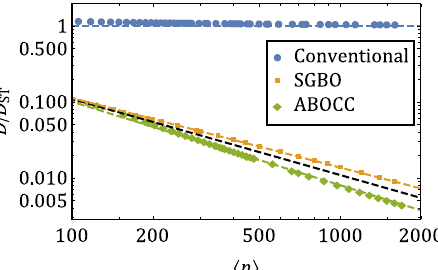
Fig. 2 Laser linewidth as a function of the average number of photons 〈 n 〉 in the laser cavity for conventional, Susskind – Glogower Bare Operator (SGBO), and Approximately Bare Operator Coupling Circuit (ABOCC) lasers. The laser linewidth is in units of the generalized Schawlow – Townes linewidth. Engineering of the atom-cavity coupling and the photon loss allows both the SGBO and the ABOCC lasers to achieve a linewidth signi fi cantly narrower than the best conventional laser. The dots represent the numerically calculated linewidth ratio. The dashed blue line represents D / D ST = 1, the expected linewidth for the conventional laser in the 〈 n 〉 → ∞ limit. The orange and green dashed lines are linear fi ts on the log-log scale of the linewidth ratio versus the mean photon number 〈 n 〉 of the SGBO and ABOCC laser, respectively. The SGBO laser D / D ST ~ 〈 n 〉 − 0.914 (orange) and ABOCC laser D / D ST ~ 〈 n 〉 − 1.098 (green). The black dashed line is a guide to the eye with D / D ST ~ 〈 n 〉 − 1